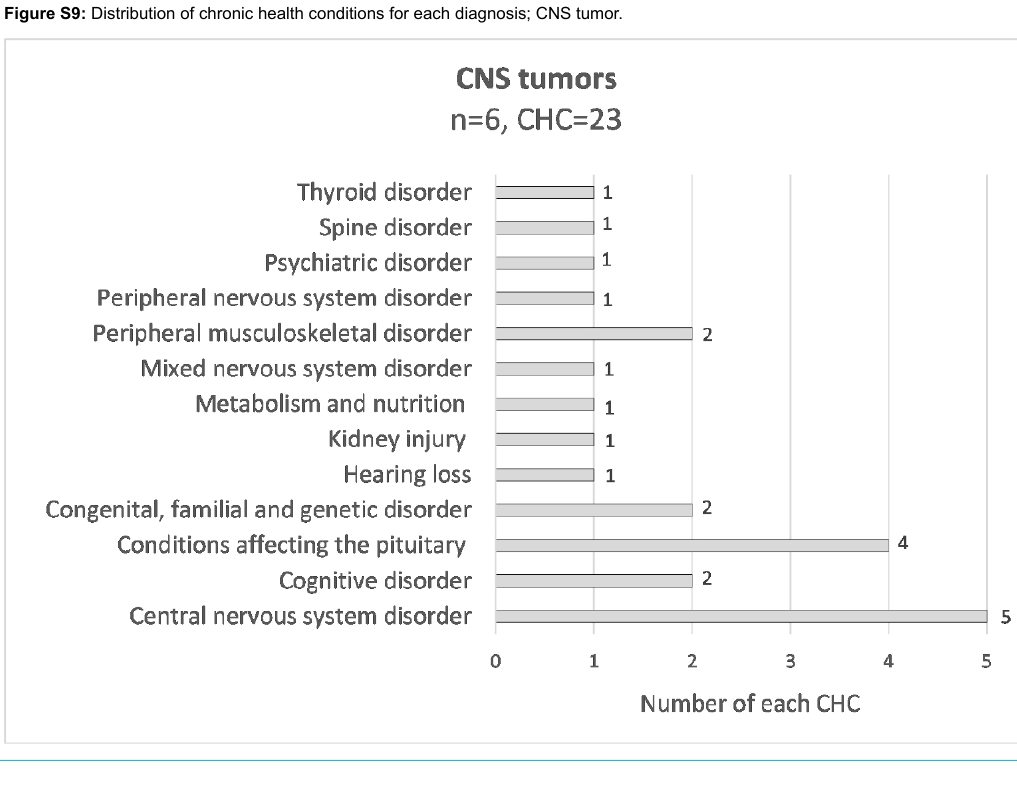
Figure S9: Distribution of chronic health conditions for each diagnosis; CNS